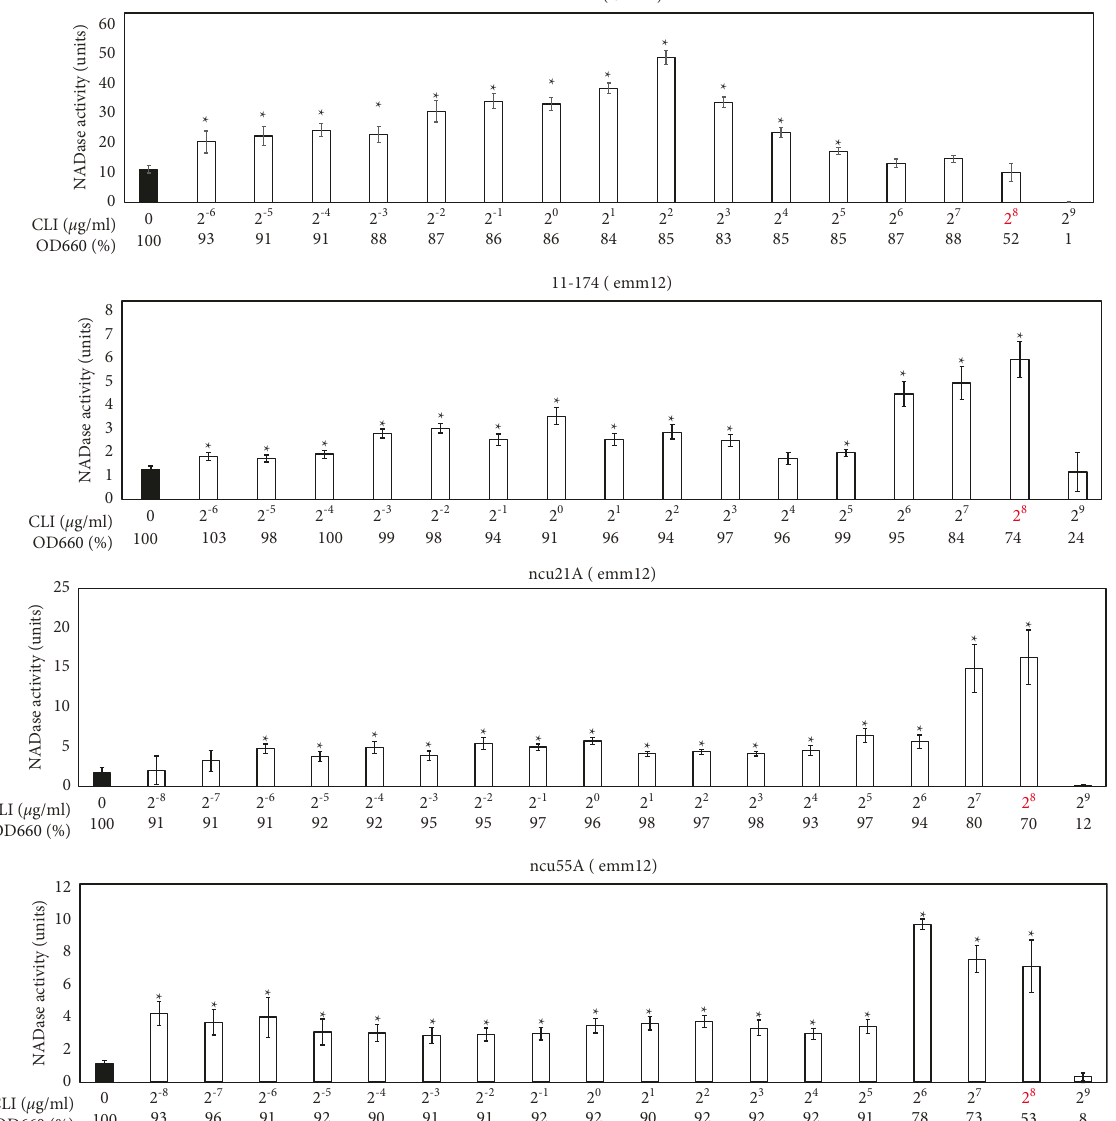
Figure 6: Extracellular NADase activity in the four CLI-resistant emm 1-or emm 12-type strains. Bacteria were cultured with CLI (2 − 6 to 2 9 μ g/ml). NADase activity was determined based on the criteria described in Figure 1. The OD 660 of overnight culture with CLI is shown by a percentage (%) of that without CLI. The maximum CLI concentration that did not suppress the bacterial growth to less than 50% of that without CLI is shown in red, which was 2 8 μ g/ml in all four strains. At least three independent experiments were performed. Error bars indicate the standard errors of the means. Significant increases in extracellular NADase activity by CLI treatment when compared with that without CLI treatment, which is shown by the black bar, are marked with asterisks ( ∗ p < 0 . 05 using Student’s t